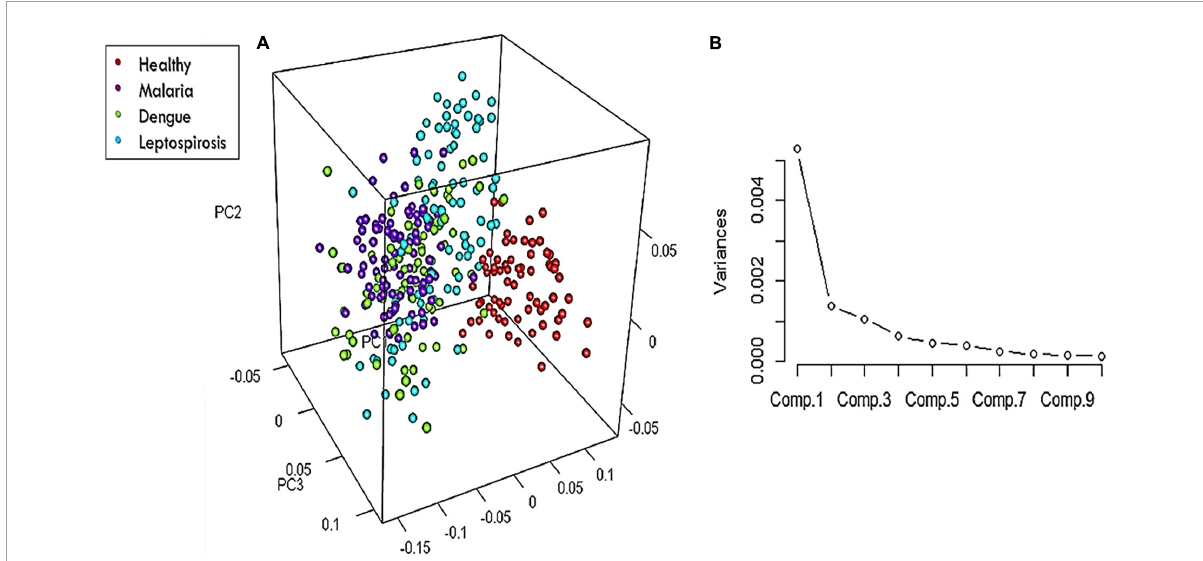
FIGURE5 (A) 3-Dimensional score-plot for the healthy and the three disease samples and (B) % Variance of the